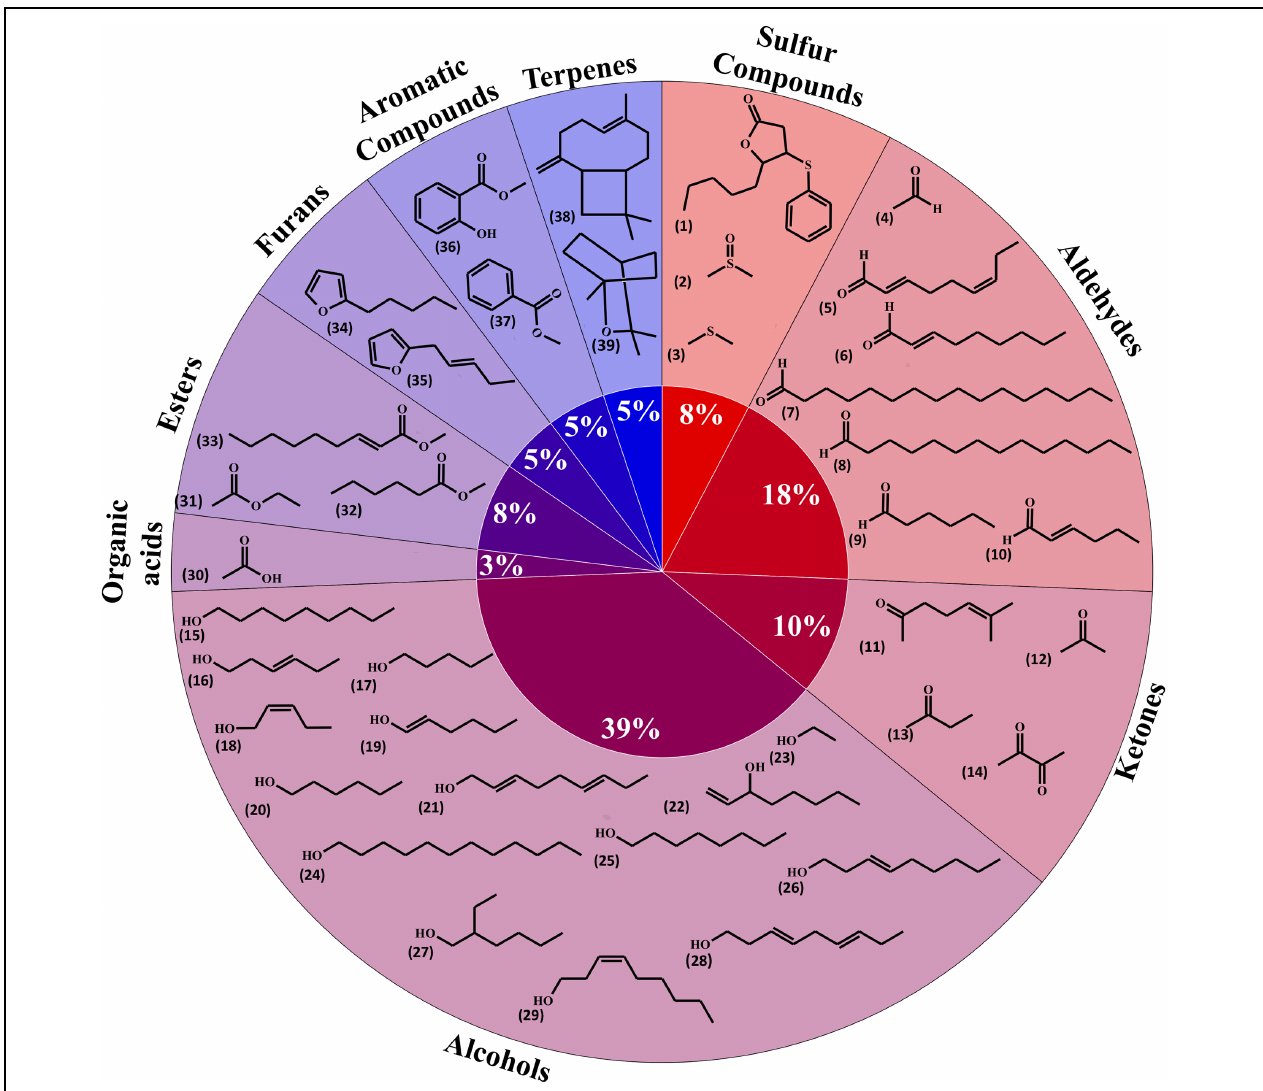
FIGURE 1 | Diversity of plant root volatiles. A total of 39 volatiles released from barley, maize, Arabidopsis or fava bean roots were classified based on their chemical classes and shown here in a pie chart. 5-Pentyl-4-phenylsulfanyloxolan-2-one (1); dimethyl sulfoxide (2); dimethyl sulfide (3); acetaldehyde (4); (2 E ,6 Z )-nona-2,6-dienal (5); ( E )-non-2-enal (6); hexadecanal (7); tetradecanal (8); hexanal (9); (2 E )-hex-2-enal (10); 6-methylhept-5-en-2-one (11); acetone (12); butan-2-one (13); butane-2,3-dione (14); nonan-1-ol (15); (3 E )-hex-3-en-1-ol (16); pentan-1-ol (17); (2 Z )-pent-2-en-1-ol (18); (1 E )-hex-1-en-1-ol (19);